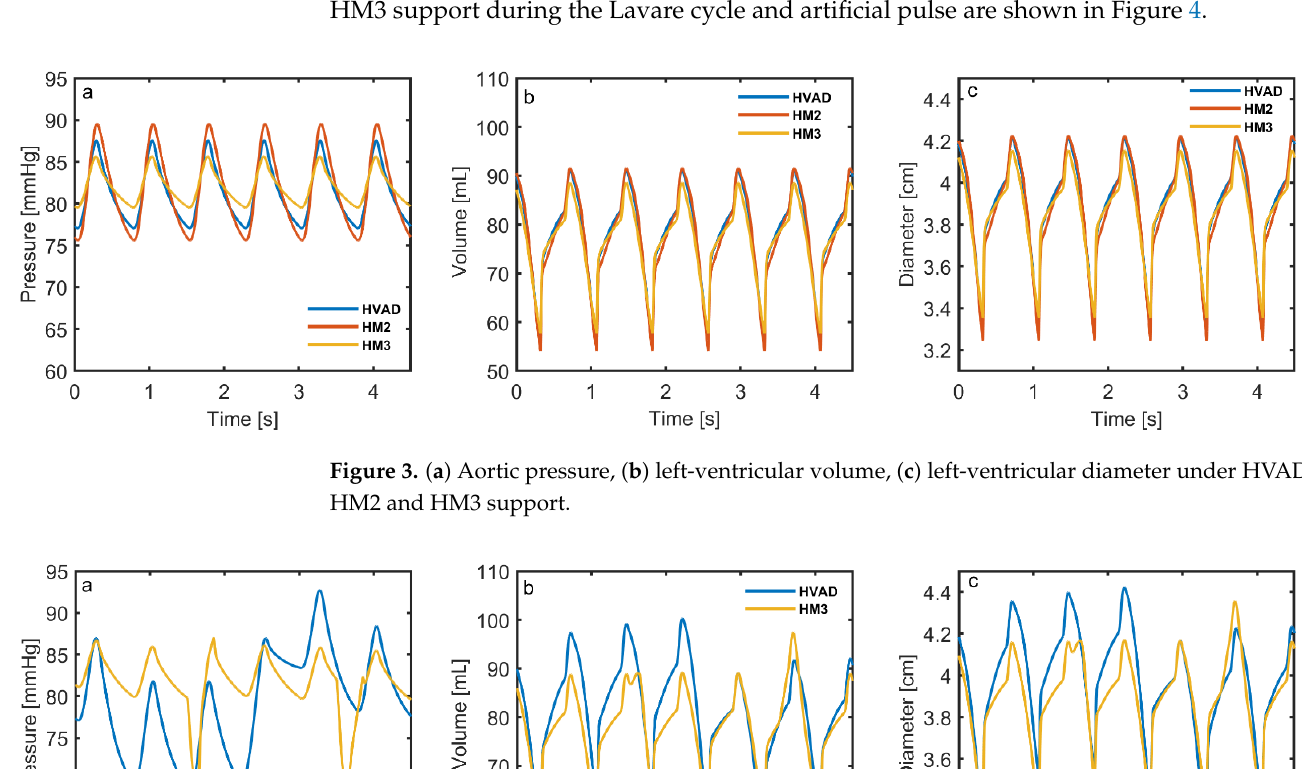
Figure 5. ( a ) Left-ventricular pressure – volume loops in the healthy and DCM cardiovascular system models, ( b ) left-ventricular pressure – volume loops under HVAD, HM2 and HM3 support, ( c ) left- ventricular pressure – volume loops under HVAD and HM3 support during the Lavare cycle and artificial